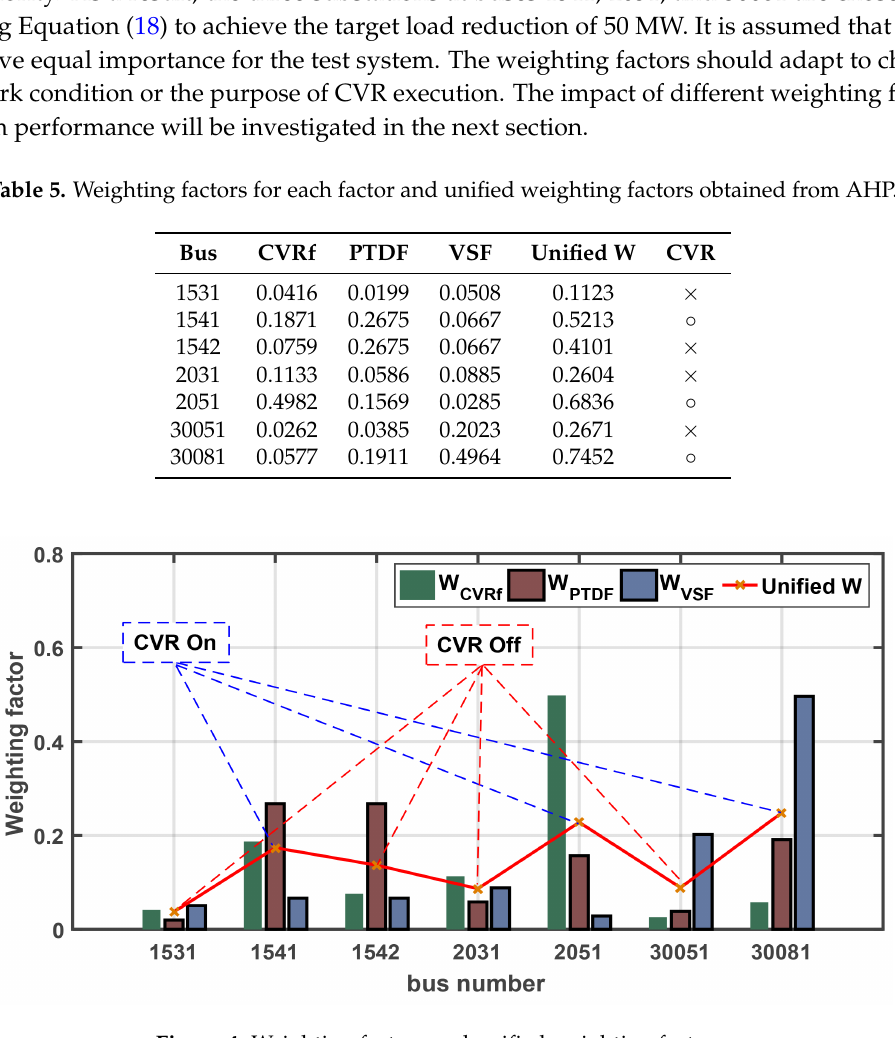
Figure 4. Weighting factors and unified weighting factors.